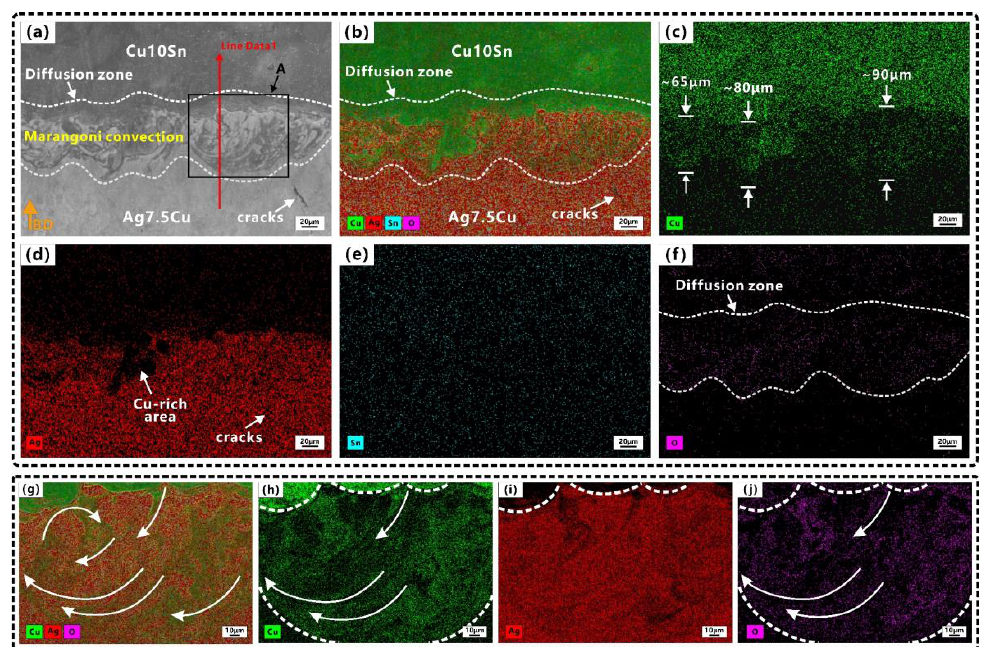
Figure 5. Elemental distributions at A/C interface: ( a ) SEM image; ( b ) EDS mapping of ( a ); ( c – f ) showing elemental distributions of Cu, Ag, Sn, O, respectively; ( g ) EDS mapping of area A in ( a ); ( h – j ) showing elemental distributions of Cu, Ag, O, respectively. Orange arrow indicates the building direction (BD).